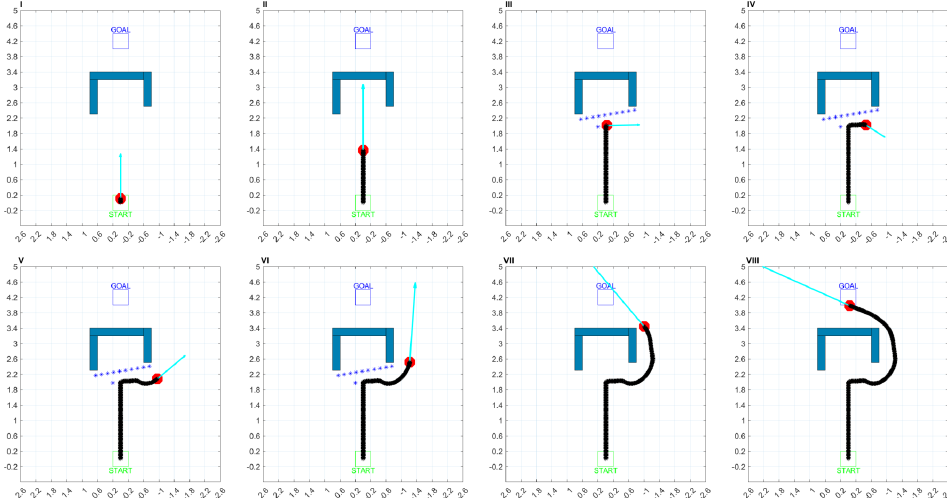
Figure 11. Results of applied AR-APF to solve the Test (II)